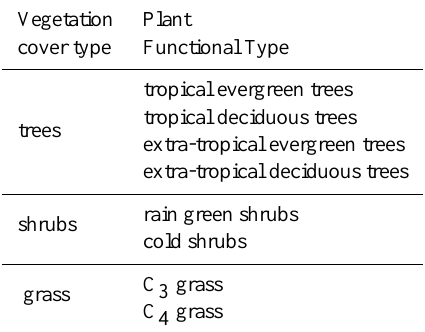
Table 1. Plant Functional Types defined in